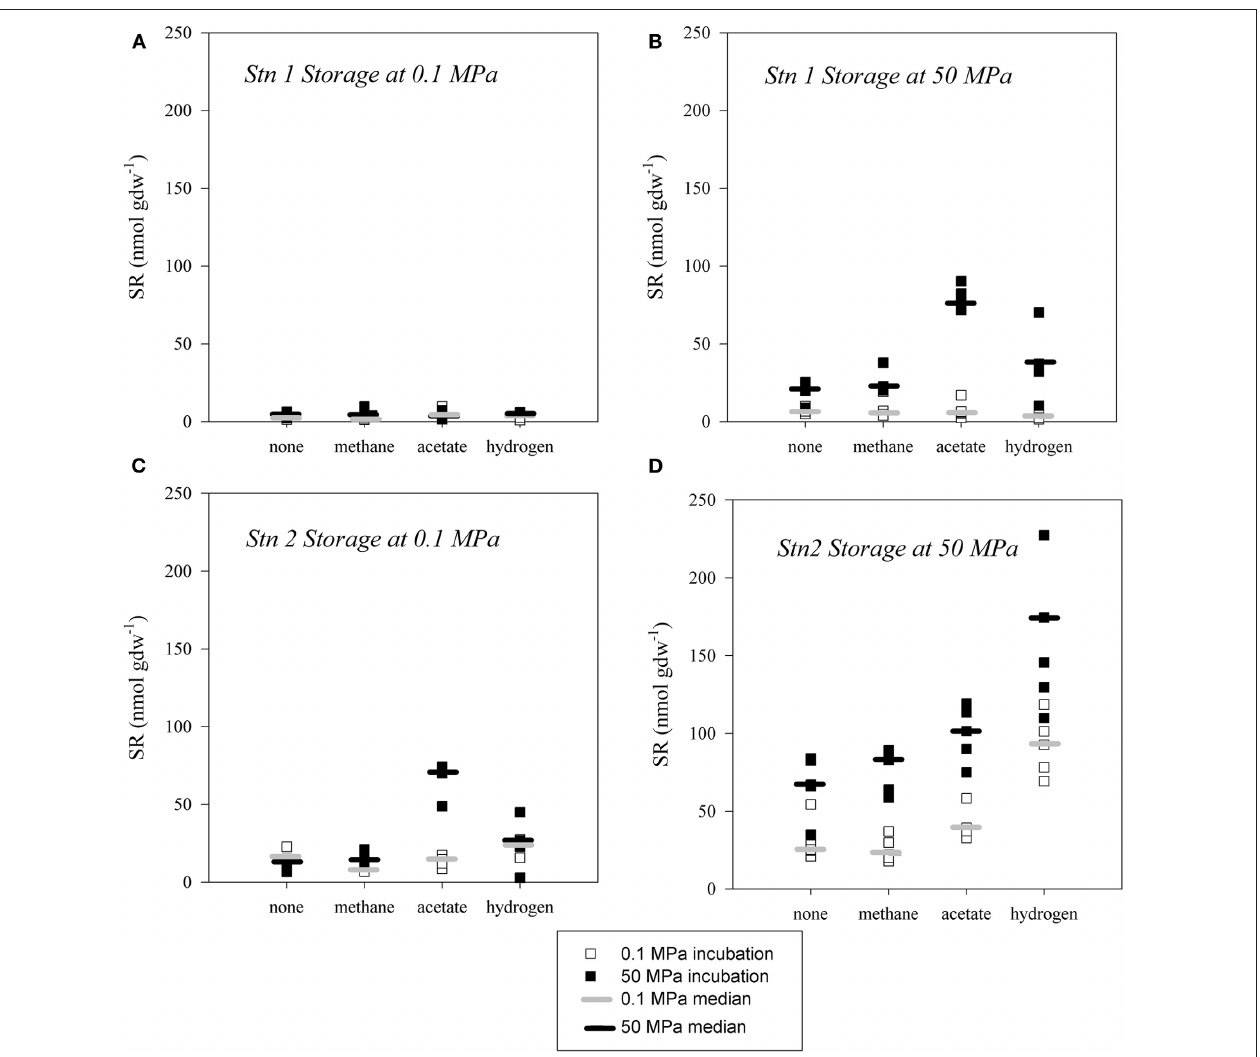
FIGURE 5 | Extent of sulfate reduction over 29 days in sediment slurries from Station 1 (A,B) and Station 2 (C,D), stored at atmospheric pressure (A,C) and at in situ pressure (B,D) under organoclastic conditions, respectively. Incubations were conducted at atmospheric pressure